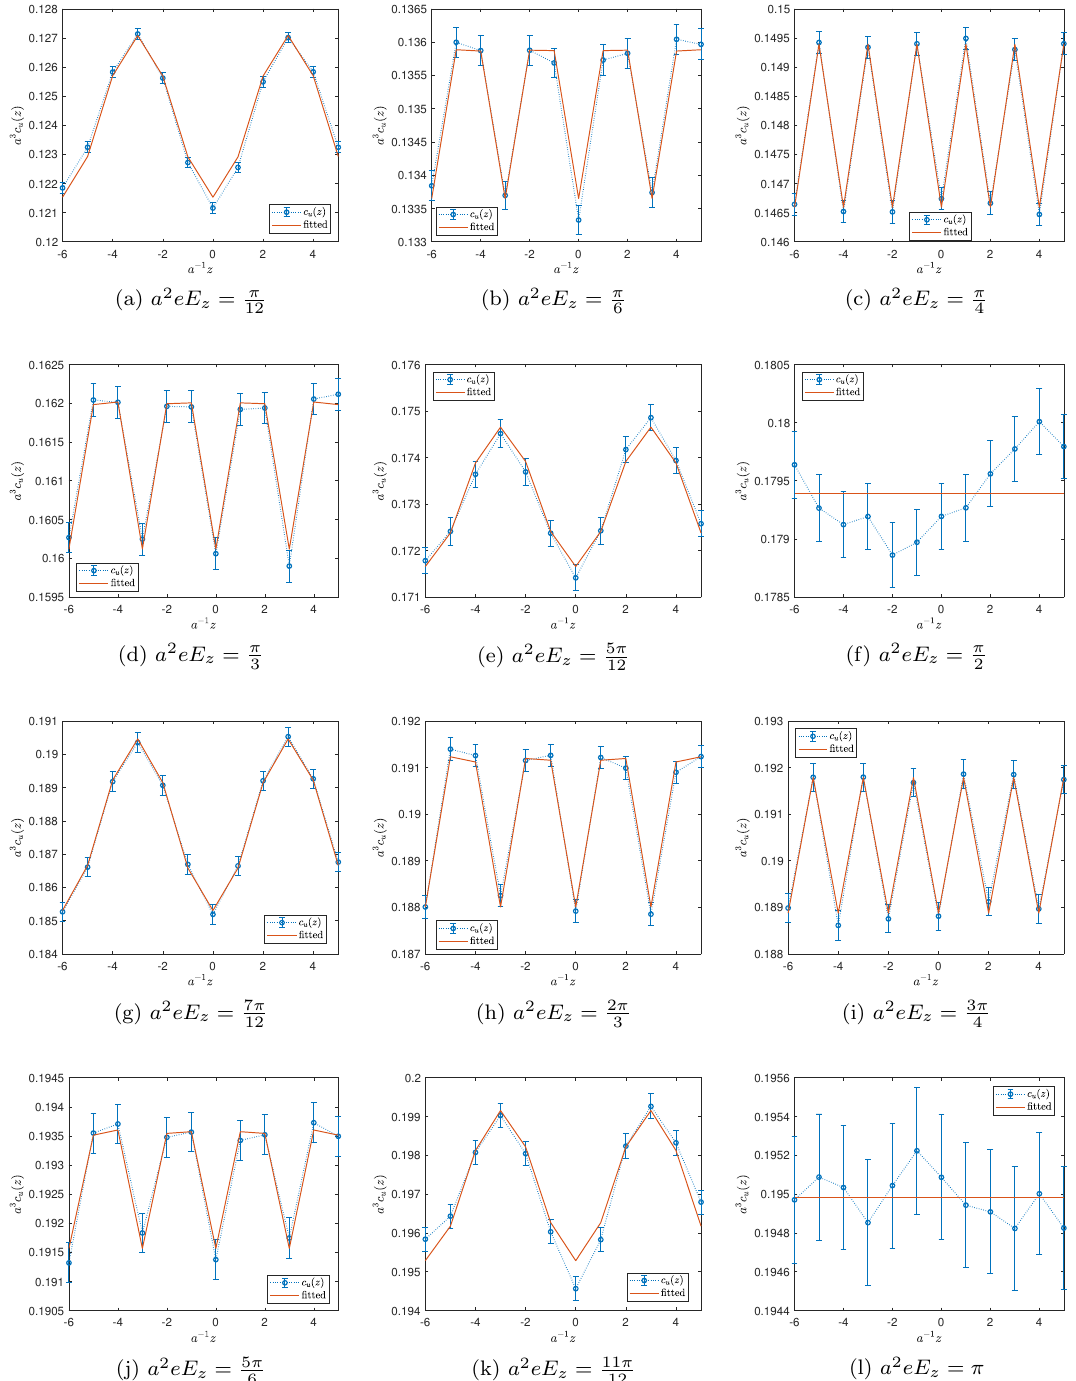
Figure 6 . c u ( z ) at β = 5 . 64 compared with the results of fittings. Note that, the dashed and solid lines are only shown for visual guidance, but not the images of c